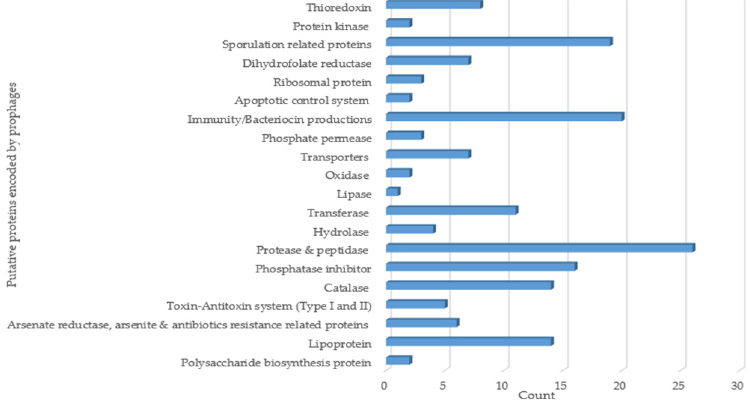
Figure 6. Functional annotation analysis of putative proteins encoded by B. subtilis prophages.